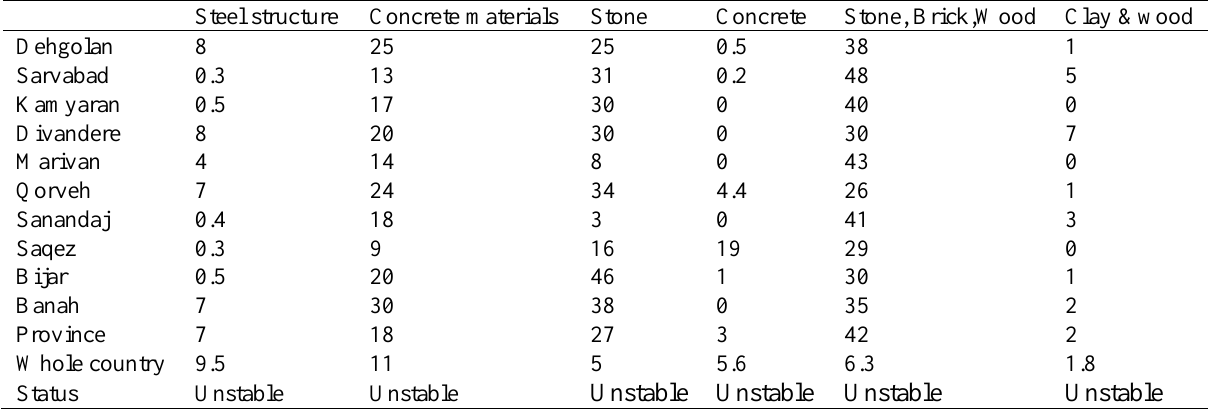
Table 2. Types of materials used in rural housing units in Kurdistan province (2013) Steel structure